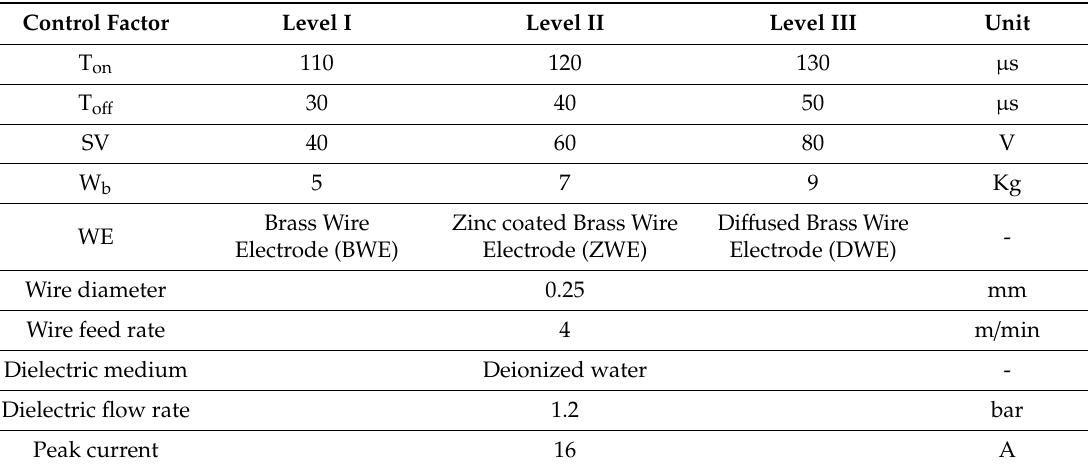
Table 1. Selection of Process